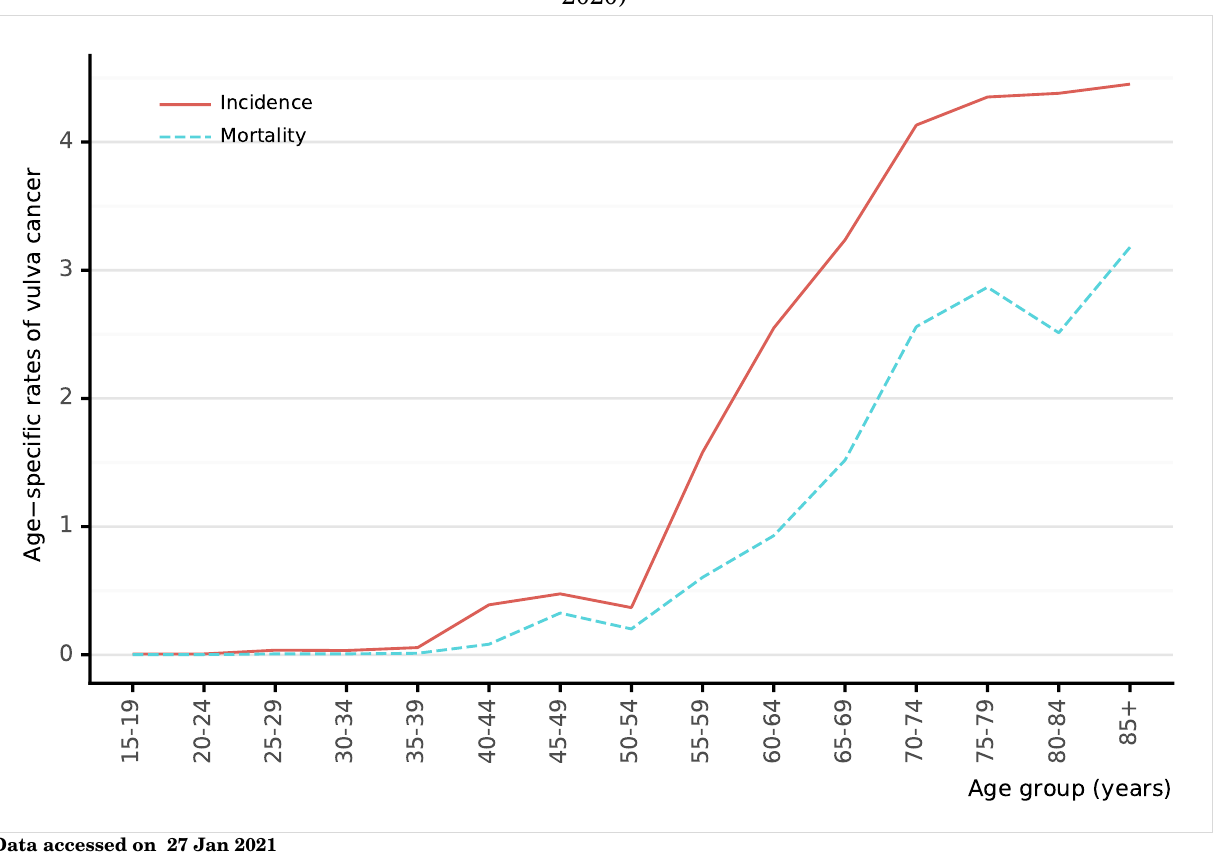
Figure 25: Comparison of age-specific vulva cancer incidence and mortality rates in India (estimates